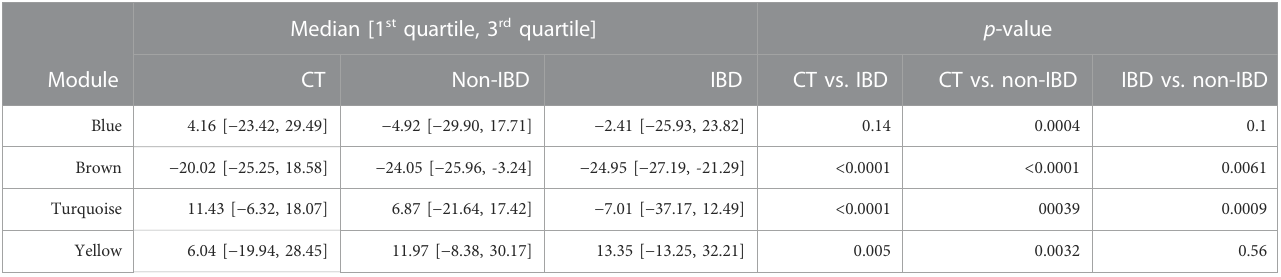
TABLE 2 Microbial module QTs in the combined control cohort as well as in affected (IBD) and unaffected (non-IBD) IBD-KC individuals. Shown are group-speci fi c medians [1st quartile, 3rd quartile] and p -values from inter-group comparisons.